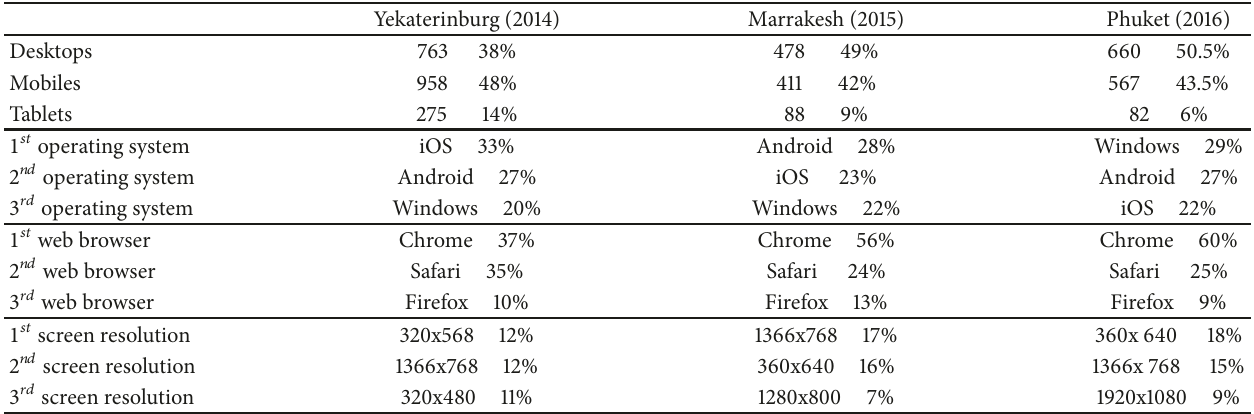
Table 4: World Finals 2014-16 local audience details